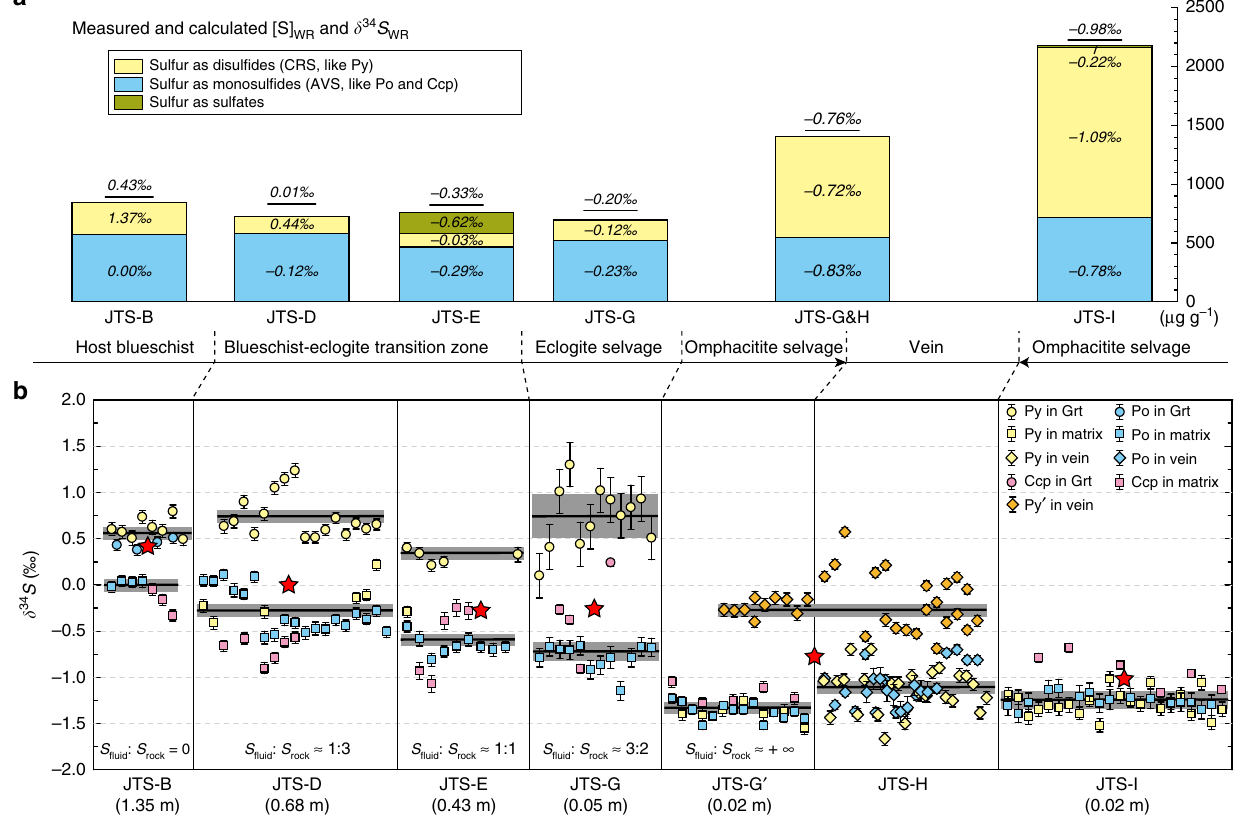
Fig. 4 Variations of bulk-rock and in situ sul fi de δ 34 S compositions along the traverse of sample JTS (Vein_1). a Calculated [S] WR and δ 34 S WR compositions based on measured whole-rock (WR) compositions of acid volatile sul fi de (AVS), chromium reducible sul fi de (CRS) and sulfate (Method 1). Rectangle height indicates sulfur content, and underlined δ 34 S values above rectangles refer to calculated δ 34 S WR compositions. Sulfate contents are mostly below the detection limits or very low. b In situ δ 34 S compositions of sul fi des along the pro fi le. Sul fi des occurring as inclusion in garnet are denoted by circles, matrix sul fi des by squares, and vein sul fi des by diamonds. Bold black lines refer to calculated δ 34 S sul fi de values (see also Supplementary Fig. 1). Vein sul fi des include two types of pyrite. Texture investigation indicates that one type (orange diamonds) is late-stage with δ 34 S around − 0.21 ‰ , which was not included in the calculation for JTS-G ’ and JTS-H. The vertical bars show the analytical errors calculated after propagating the within-run and external uncertainties of standard measurements. Red stars show δ 34 S WR compositions from a . Mineral abbreviations: chalcopyrite (Ccp), garnet (Grt), pyrite (Py), and pyrrhotite (Po). Source data are provided in Supplementary